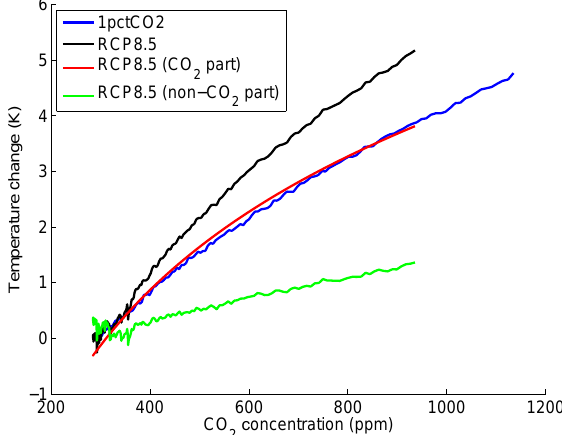
Figure 8. Decomposition of global mean temperature change (as a function of the CO 2 concentration) into its components, as de- scribed in Sect.